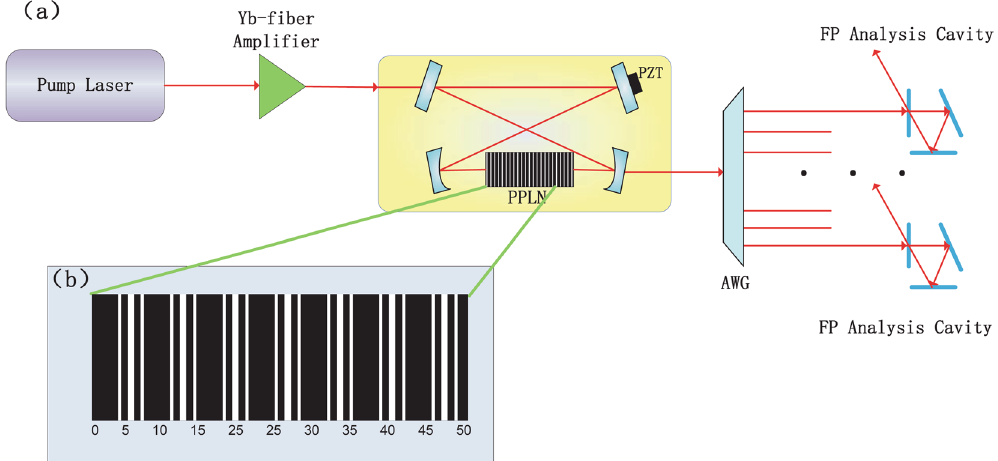
Figure 3. Experimental setup. ( a ) A four-mirrors travelling wave cavity, with a PPLN crystal, is pumped by an amplified cw laser. The nonlinear cavity output beams are separated by an arrayed waveguide grating (AWG) and then analyzed by the Fabry-Perot (FP) analysis cavities. ( b ) The structure of the PPLN